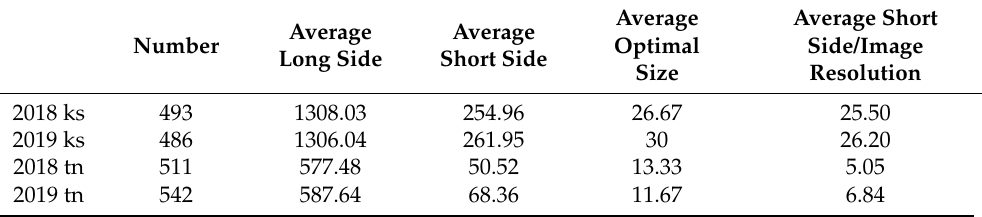
Table 5. The relationship between the optimal segment size and the side length of the